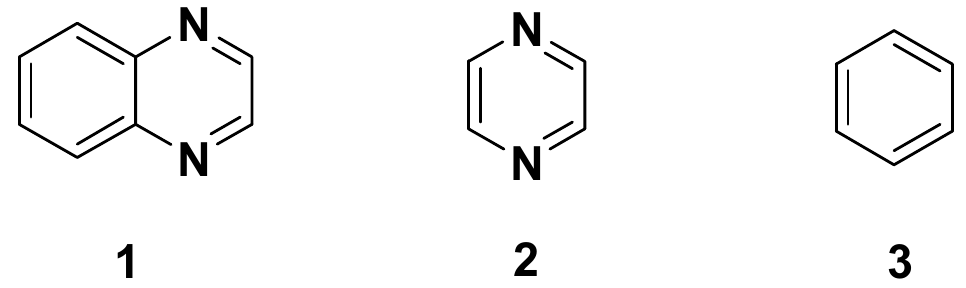
Figure 1. Structures of quinoxaline, pyrazine and benzene.